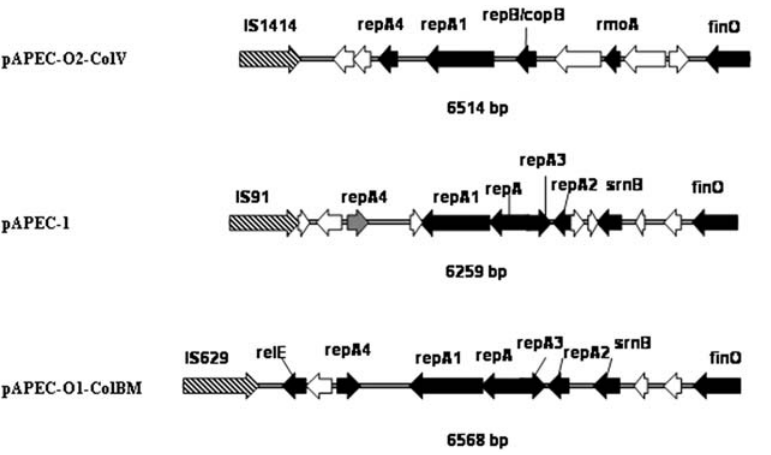
Figure 4. Comparison of the genetic map of the replication region of pAPEC-1 to that of pAPEC-O2-ColV (NC_007675) and pAPEC- O1-ColBM (NC_009837). Black arrows represent known ORFs genes, grey arrows represent truncated genes, and white arrows represent hypothetical protein genes and hatched arrows are Insertion Sequences genes.